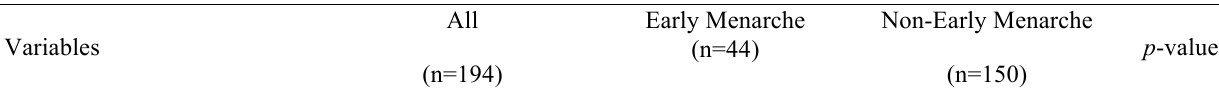
Table 2 Subjects’ metabolic profiles based on early menarche